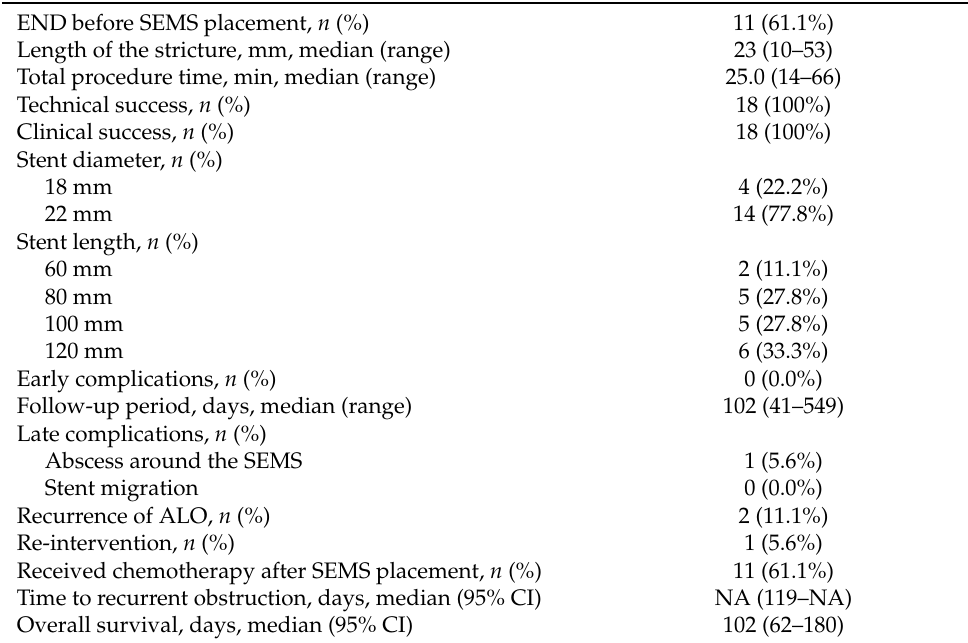
Table 3. Endoscopic procedure and long-term outcomes of the SEMS cohort ( n = 18).